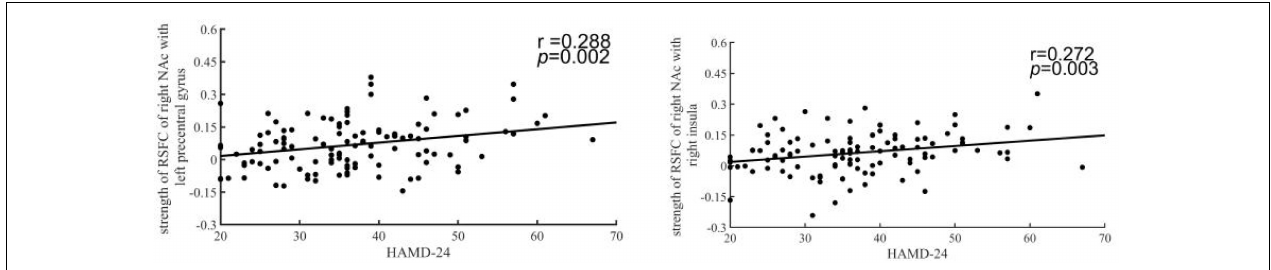
FIGURE 4 | The HAMD-24 scores were correlated with decreased resting-state functional connectivity (RSFC) of the nucleus accumbens (NAc). The y-coordinate meant HAMD-24 scores. The x-coordinate meant the z-score of RSFC in